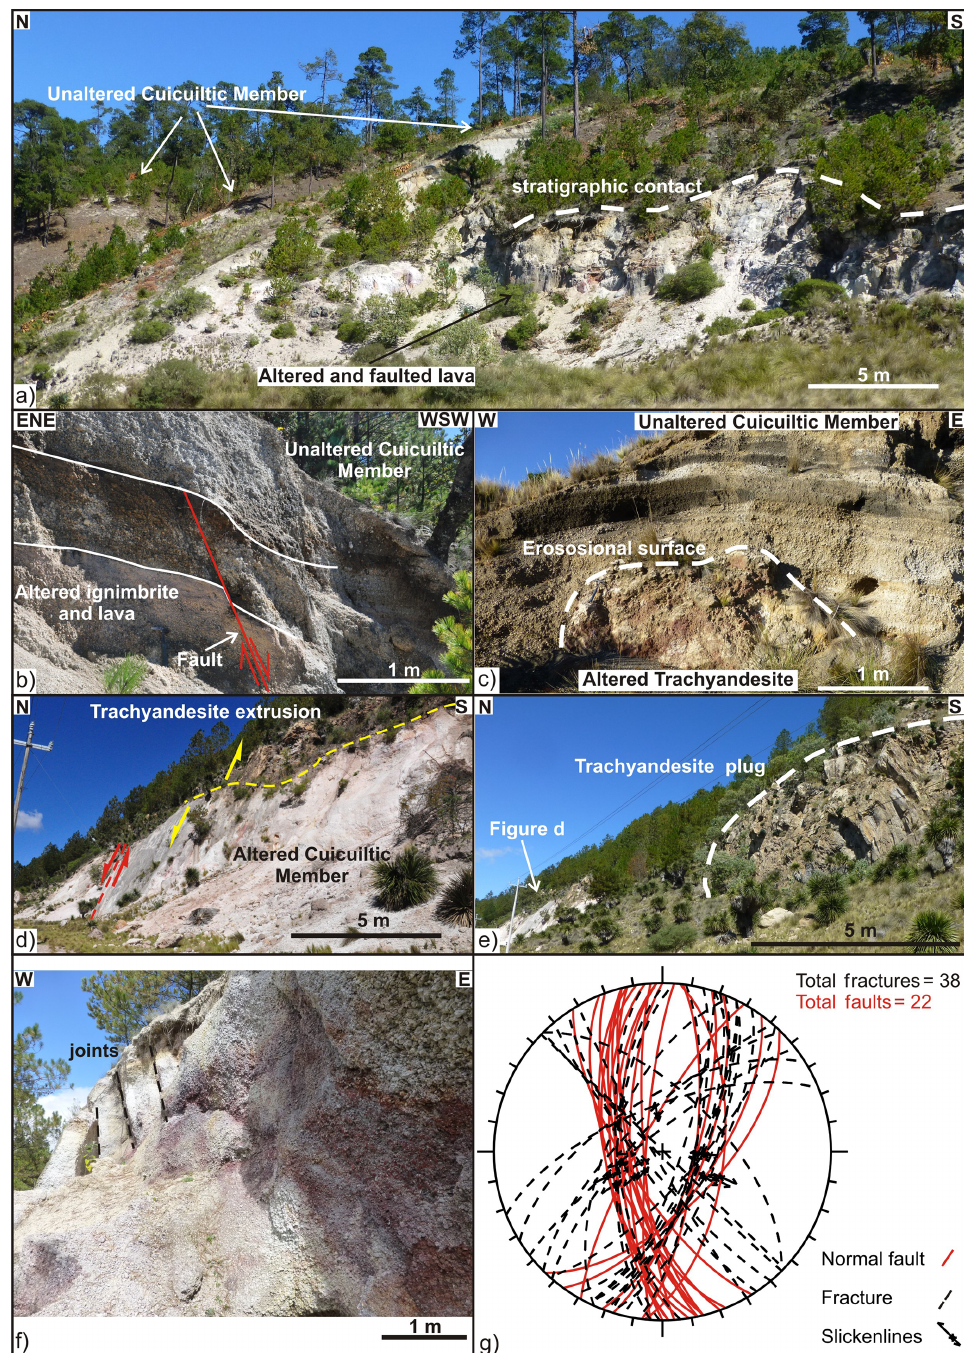
Figure 6. (a) Panoramic view of the Arroyo Grande fault scarp showing the unaltered Cuicuiltic Member covering the altered and faulted ignimbrite and lavas (site LH-09). (b) Normal fault affecting the altered ignimbrite deposits unconformably covered by the post-caldera, unaltered Cuicuiltic Member deposits (LH-09). Note that the Cuicuiltic Member deposits are not faulted at this location; the fault can thus be considered a fossil fault with respect to the Cuicuiltic Member deposition. (c) Block of altered trachyandesite buried by unaltered Cuicuiltic Member layers along the Maxtaloya fault scarp. (d) Los Humeros Fault scarp (LH-10) induced by the ascent of the trachyandesitic extrusion on top of the fault plane. (e) Trachyandesite plug cropping out ∼ 150 southward of the fault scarp shown in (d) (indicated by the red arrow). (f) Jointing and alteration of the Cuicuiltic Member within the apical depression of the Loma Blanca dome (LH-01). (g) Equal-area stereo plot of the attitudes of faults and fractures in all the structural